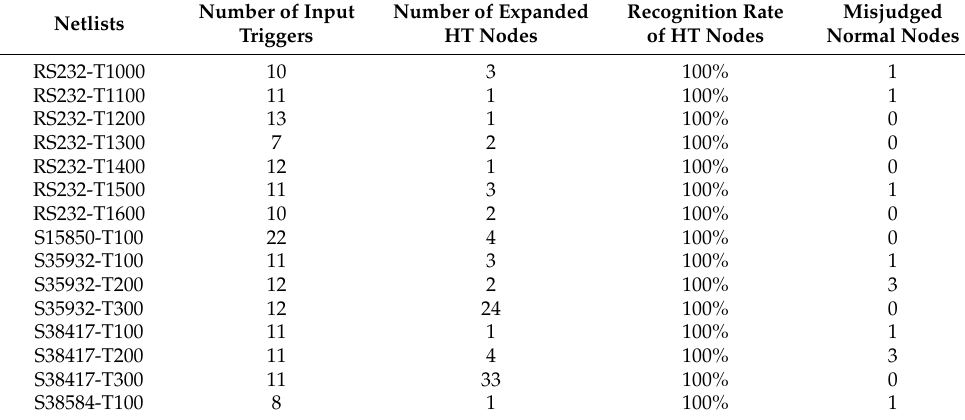
Table 5. Result of load